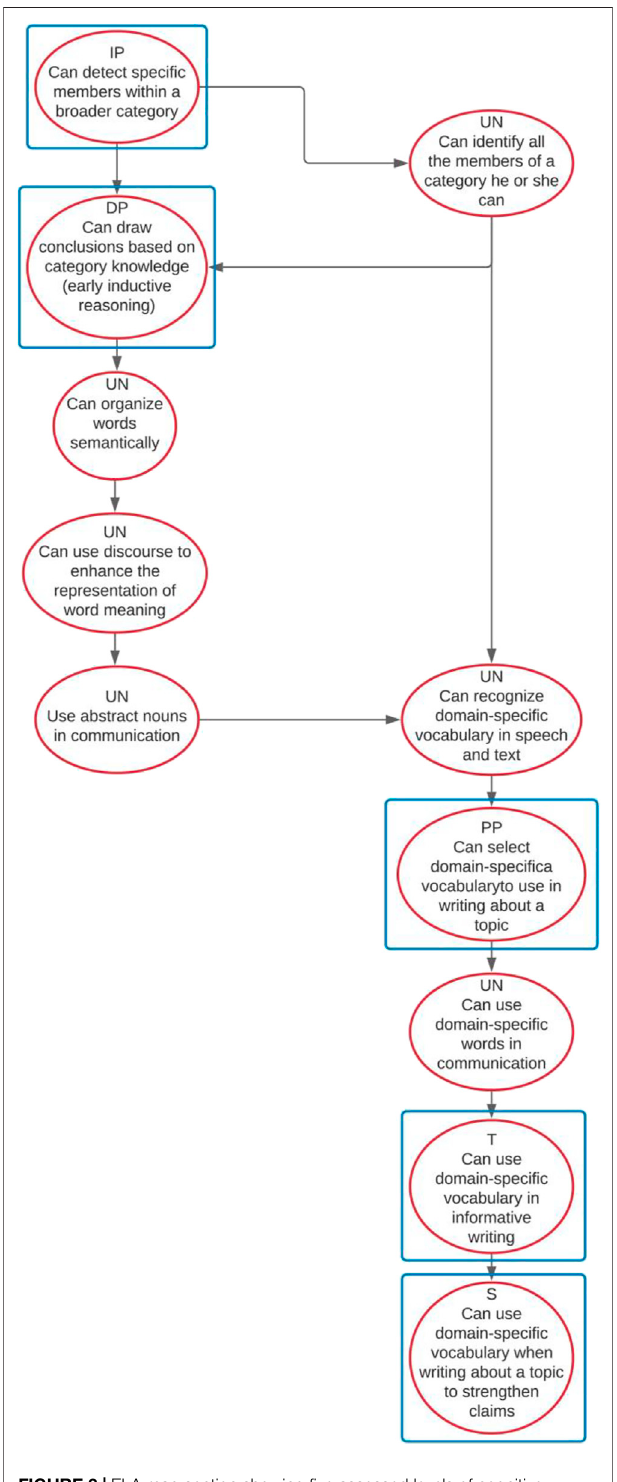
FIGURE 3 | ELA map section showing fi ve assessed levels of cognitive complexity for the grade 8 EE: Use domain speci fi c vocabulary related to the topic (ELA.EE.W.8.2.d). Rectangles indicate tested nodes. Linkage level abbreviations:, initial precursor — IP, distal precursor — DP,